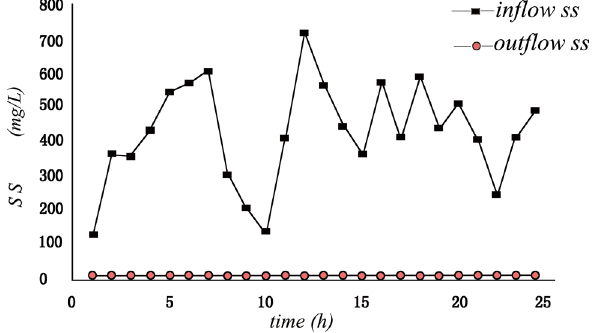
Fig. 11 Comparison of TP value before and